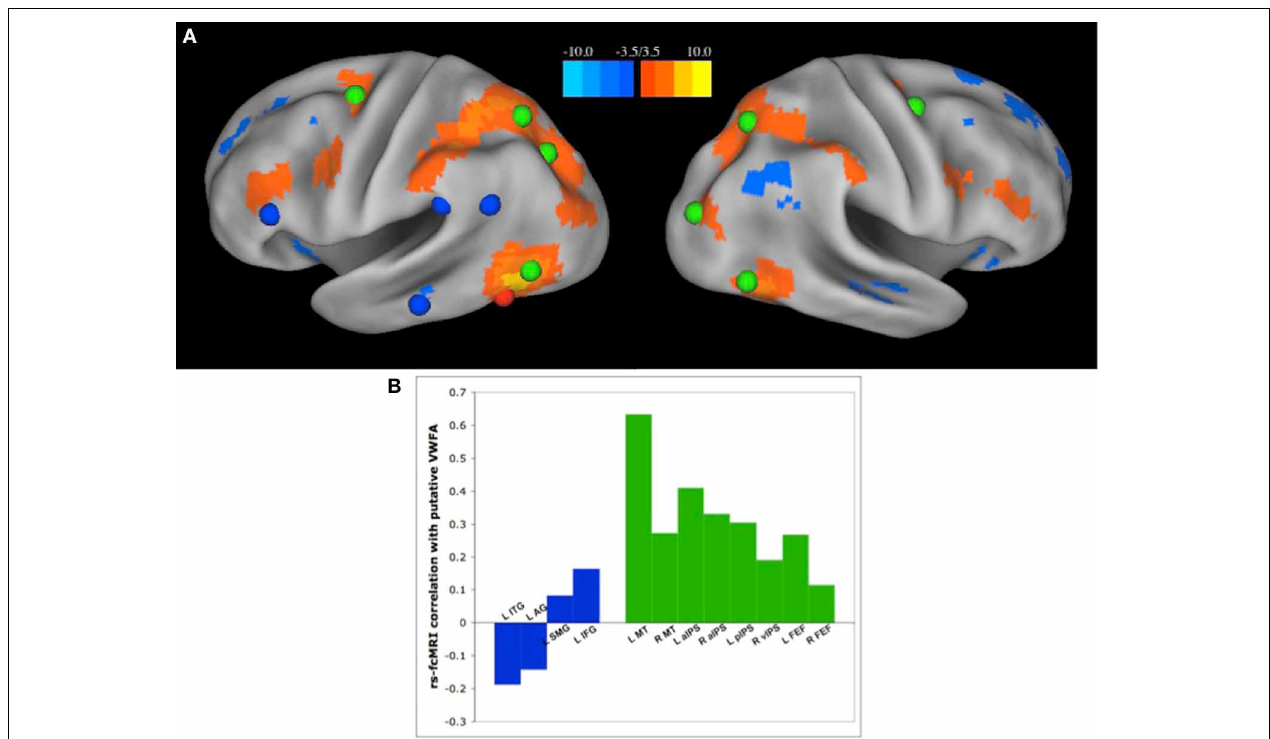
FIGURE 3 | The VWFA has stronger RSFC correlations with regions of the dorsal attention network than “reading related” regions. (A) Seed map of voxels with the strongest RSFC correlations to the putative VWFA, as defined in a meta-analysis of single word reading studies. Positive correlations in RSFC are shown in warm colors, negative correlations shown in cool colors. The location of regions of the dorsal attention network are